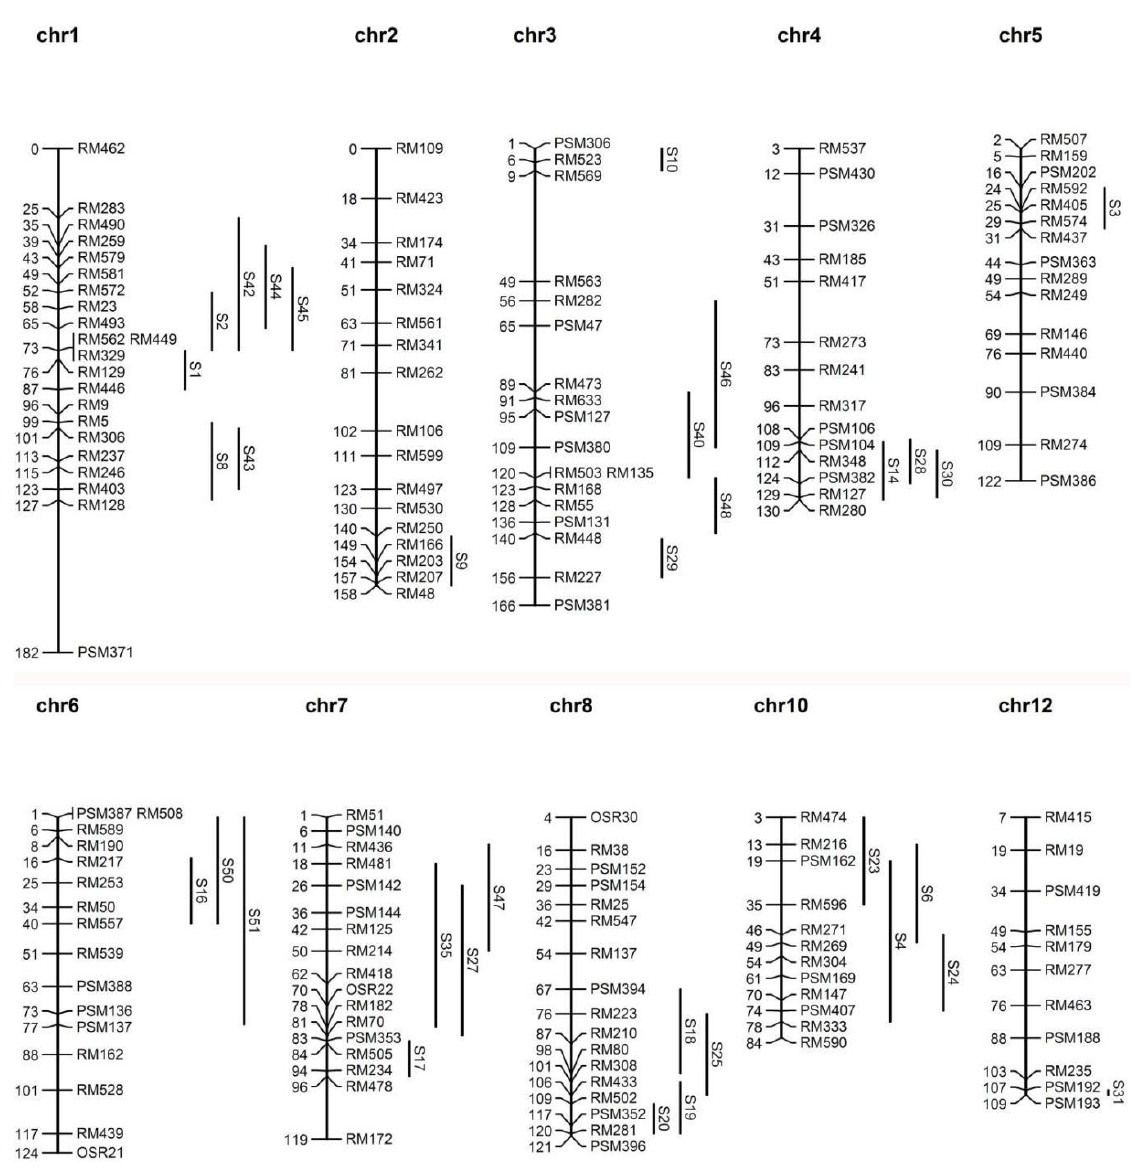
Figure 1. Distribution of the 33 single-segment substitution lines in chromosomal marker intervals. Substituted segments are represented by black lines. Symbols on the right of each segment indicate the abbreviations of the experimental materials. Codes on the left and right sides of each chromosome indicate the designated centimorgan (cM) and molecular markers, respectively.